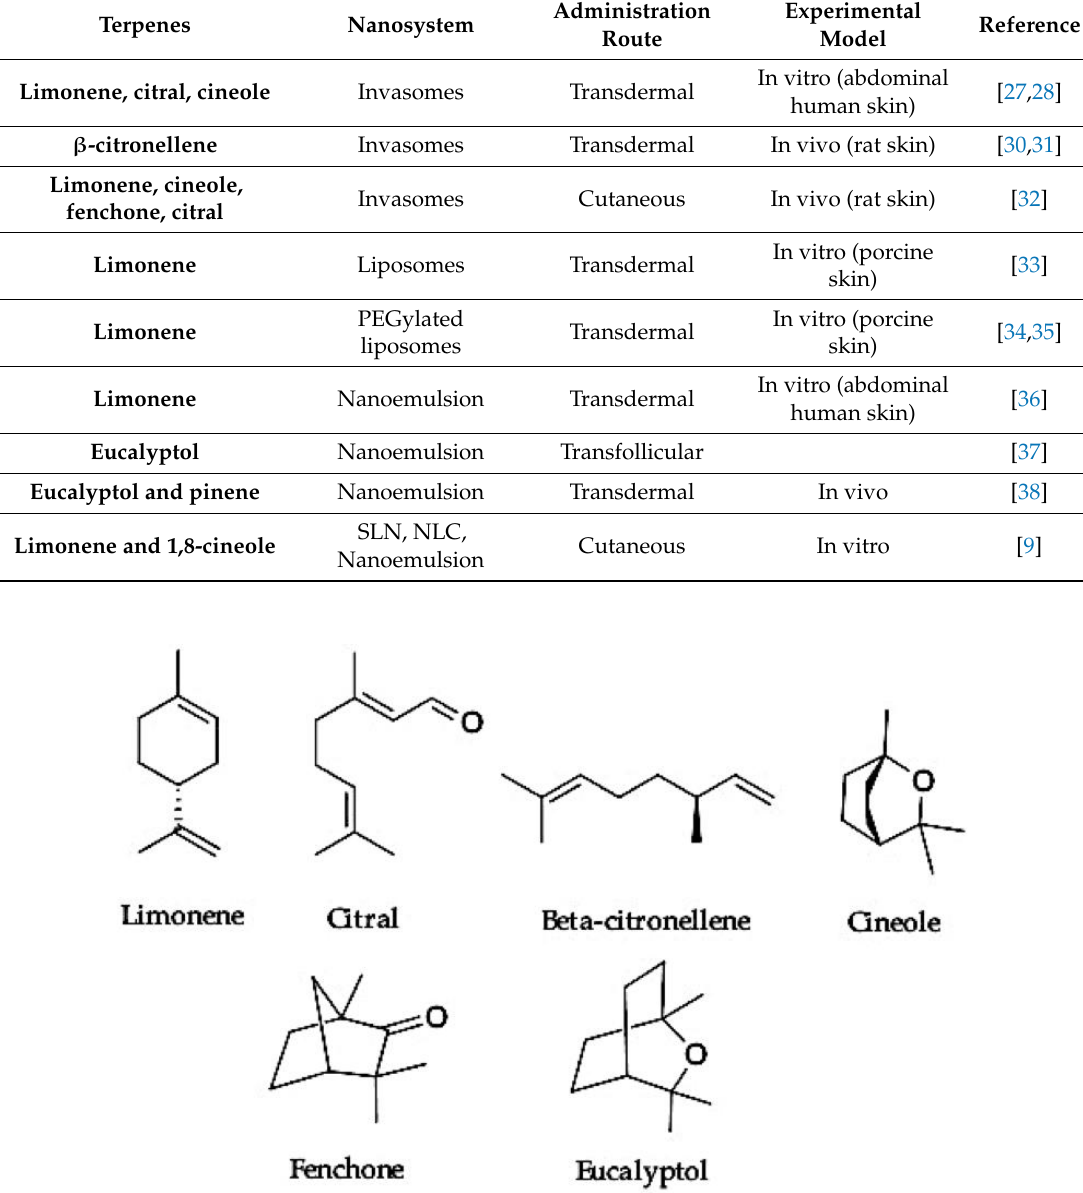
Table 2. Terpenes as bioactive compounds encapsulated in lipid-based nanosystems for anti- inflammatory treatment. Terpenes/Terpenoids